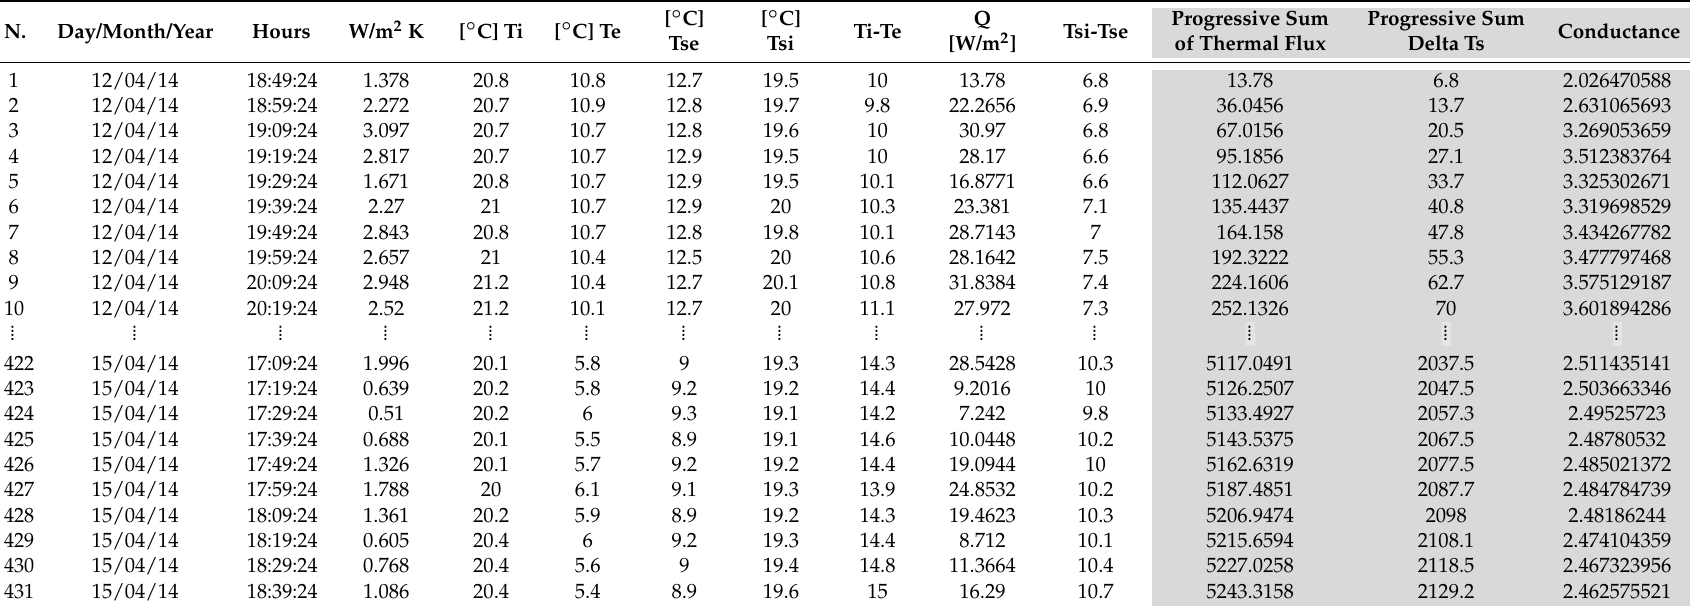
Table 2. On the left side, the data detected by the thermal flux meter Tabular output. In particular, in the table there are data concerning the first and the last 10 measurements, so as to highlight the variation of the parameters involved in the measurement. On the right side, against the grey background, the calculation of the variables of the Equation (1) has been inserted.